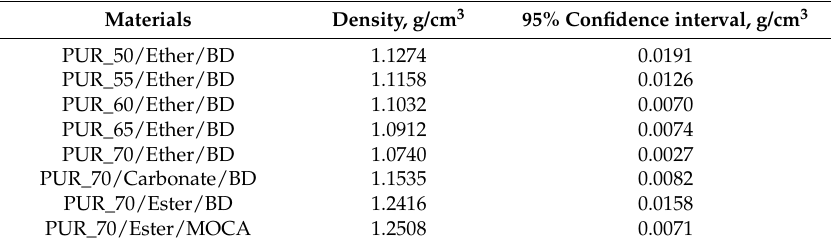
Table 3. The density of prepared PUR. The 95% confidence interval is indicated with SO2602:1980. Materials